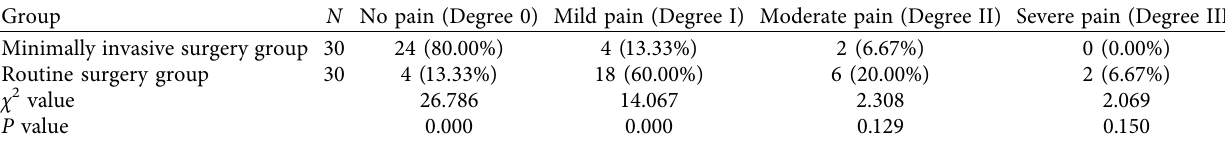
Figure 1: Comparison of perioperative indicators between the two groups. (a) Operation time. (b) Antibacterial use time. (c) Swelling degree. ∗ P < 0 . 05. Table 1: Comparison of pain between the two